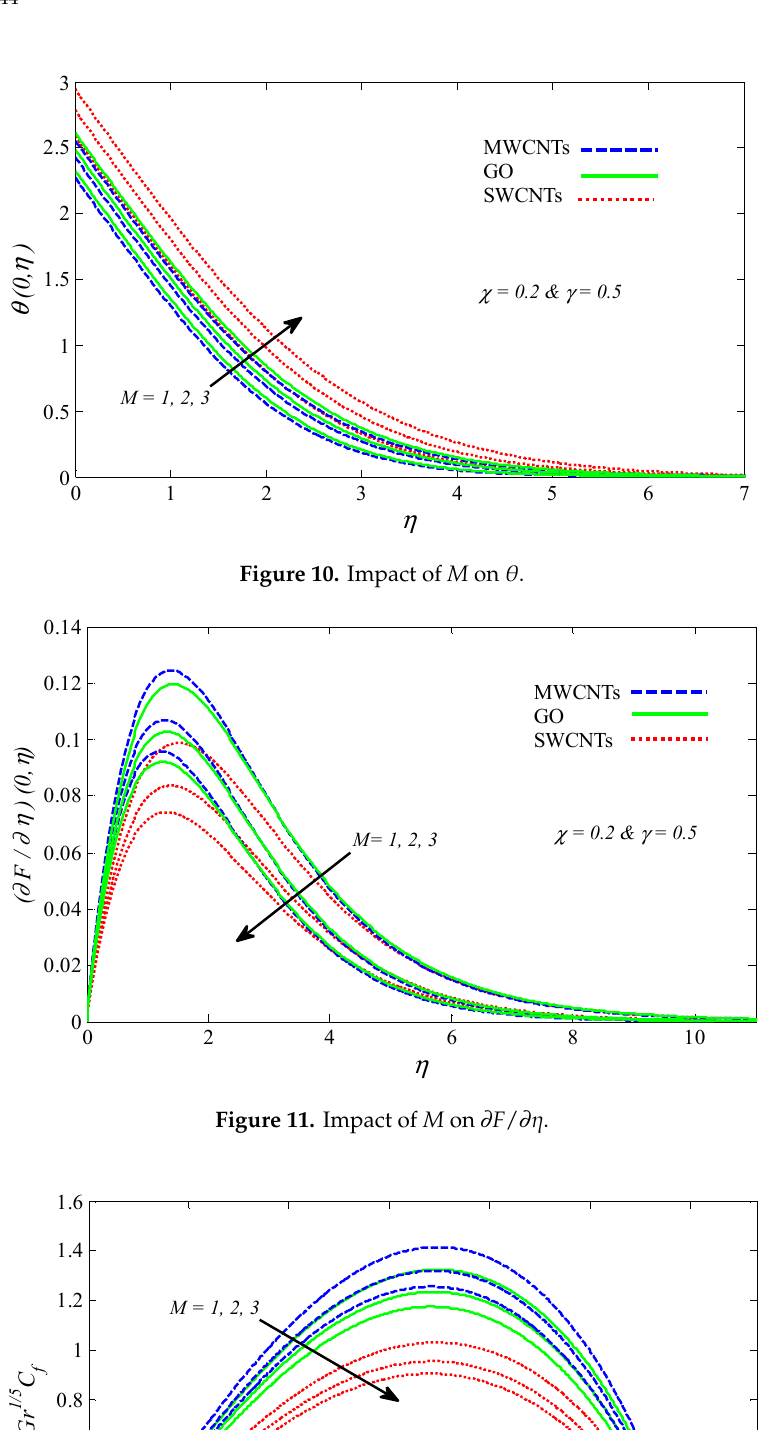
Figure 12. Impact of M on Gr 1/5 C f